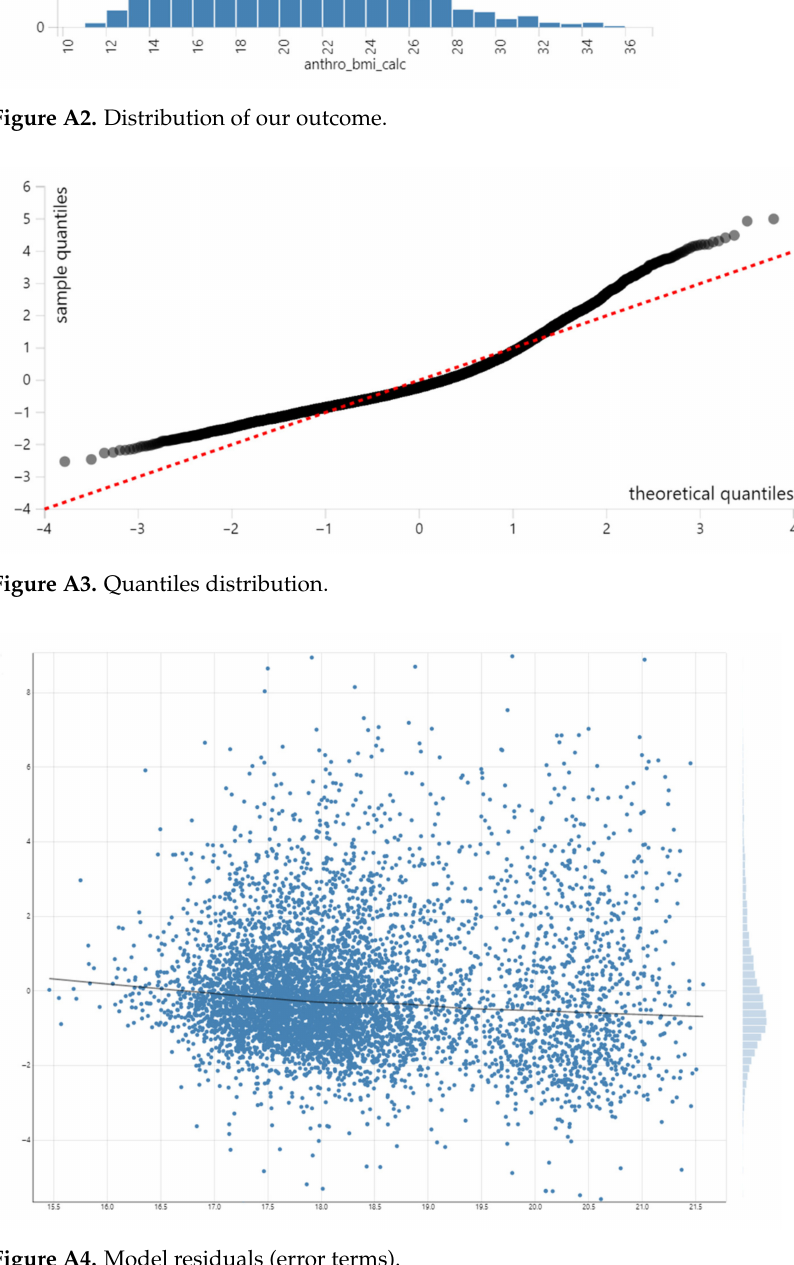
Figure A4. Model residuals (error